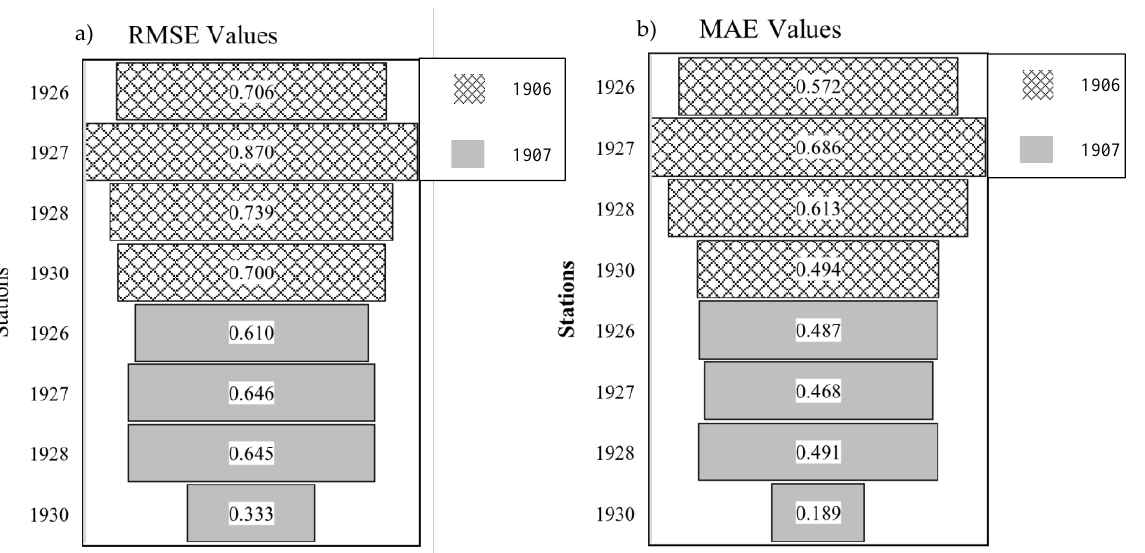
16 of 20 Figure 12. Raw and bias-corrected SDI values comparison. (a) 1926 and 1906, (b)1927 and 1906, (c) 1928 and 1906, (d) 1930 and 1906, (e) 1926 and 1907, (f)1927 and 1907, (g) 1928 and 1907, (h) 1930 and 1907. Linear regression line represented with yellow line. It was determined that this situation occurred in direct proportion to the R values, and, accordingly, as a result of the DAR method, the most suitable station match for mov- ing to the nearest station was 1930 – 1907, and the least compatible match was 1927 – 1907.